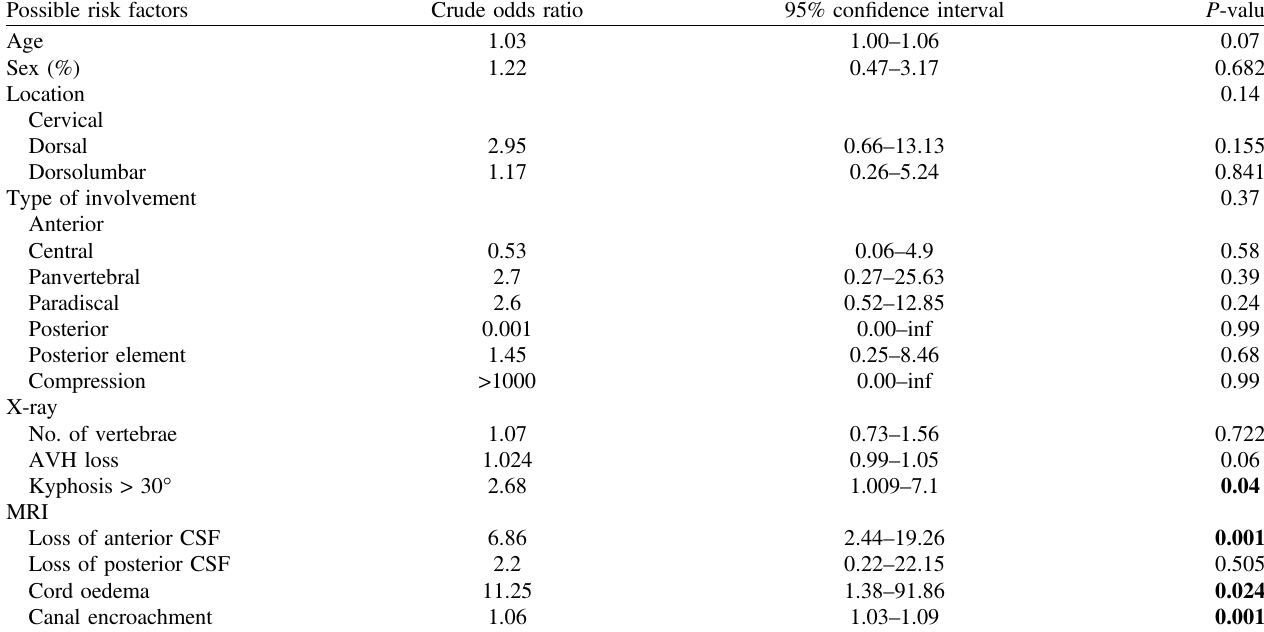
Table 2. Univariate analysis.